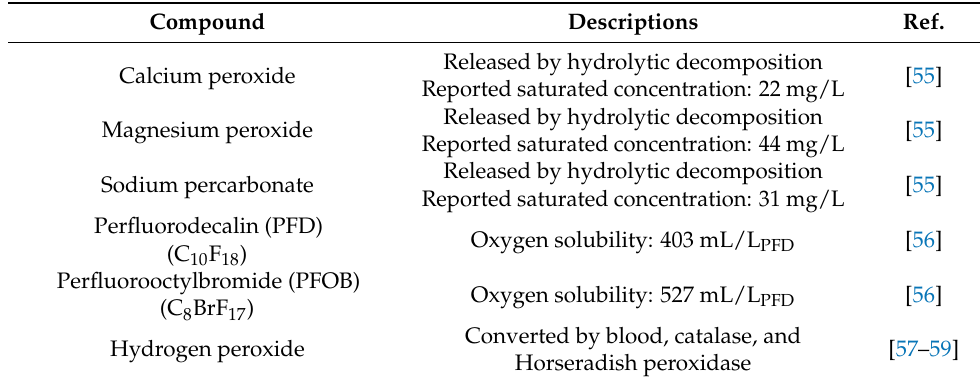
Table 2. Examples of oxygen releasable compounds and their characteristics.